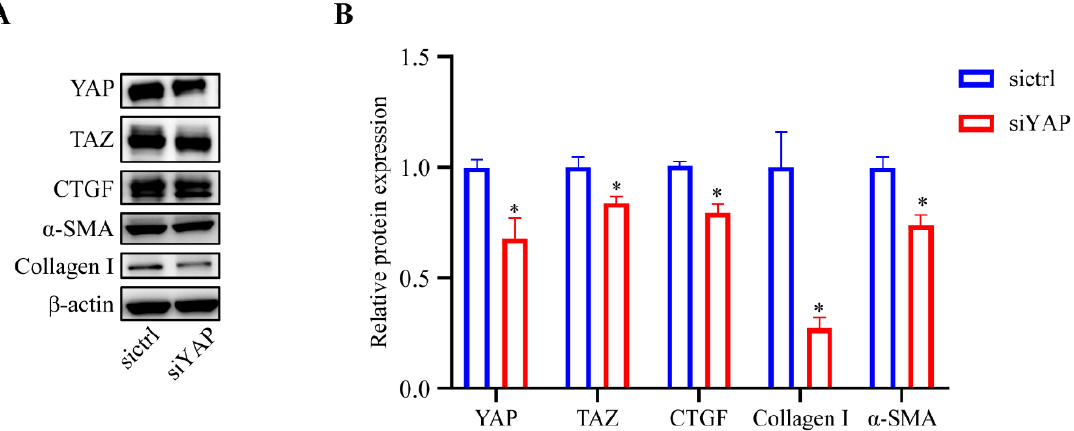
Figure 5. Inhibition of YAP decreased the expression of CTGF, Collagen I, and α -SMA. ( A ) Cells treated with siYAP showed significantly decreased expression levels of YAP, TAZ, CTGF, α -SMA, and Collagen I compared with control cells based on western blot analysis. ( B ) Quantification analyses of YAP, TAZ, CTGF, α -SMA, and Collagen I expression levels. * p < 0.05.